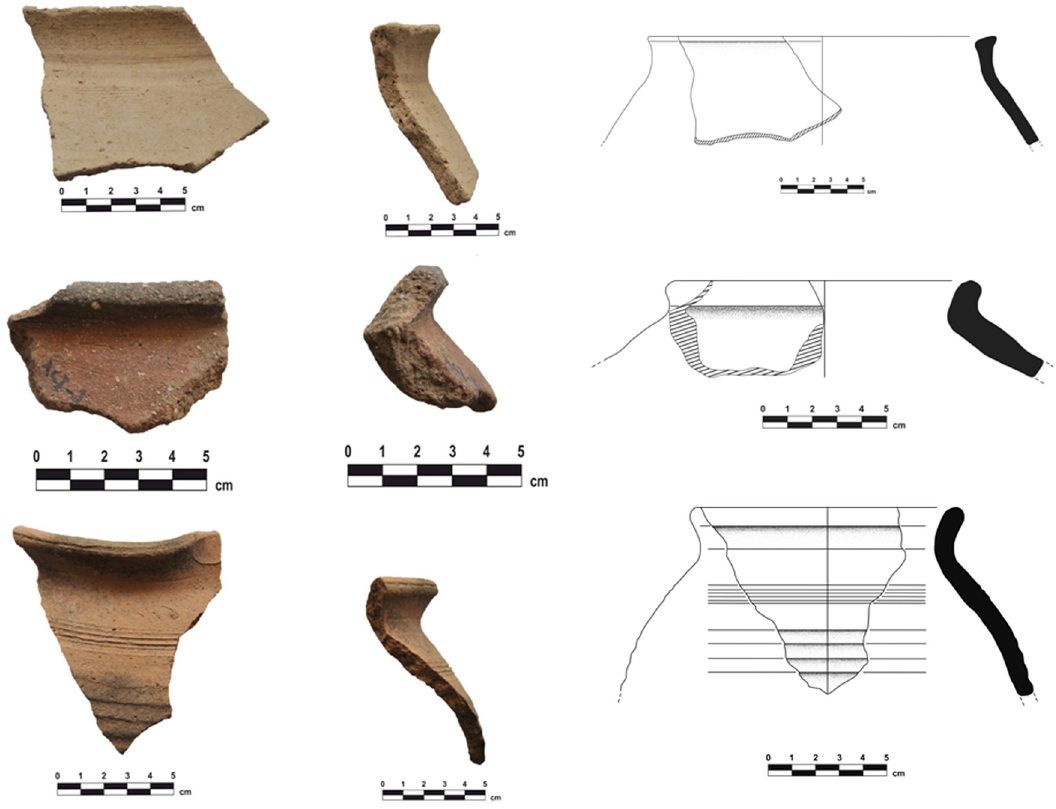
Figure 16: Samples of some commonly found sherds and pro fi les ( left and middle ) and selected drawings ( right ) ( Ambarçay Salvage Excavation Archive )